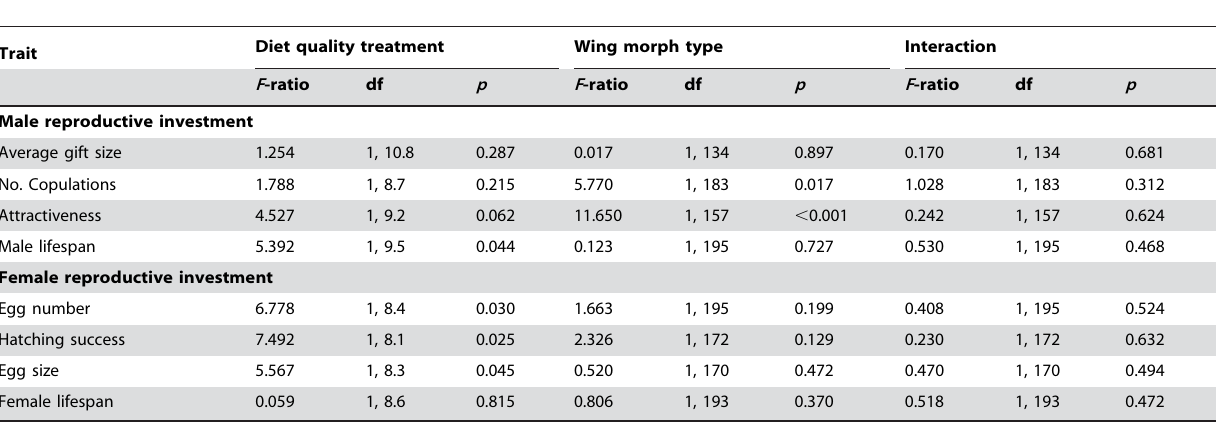
Table 2. The mixed model analyses for the effects of diet quality treatment and wing morph type on estimates of male and female reproductive